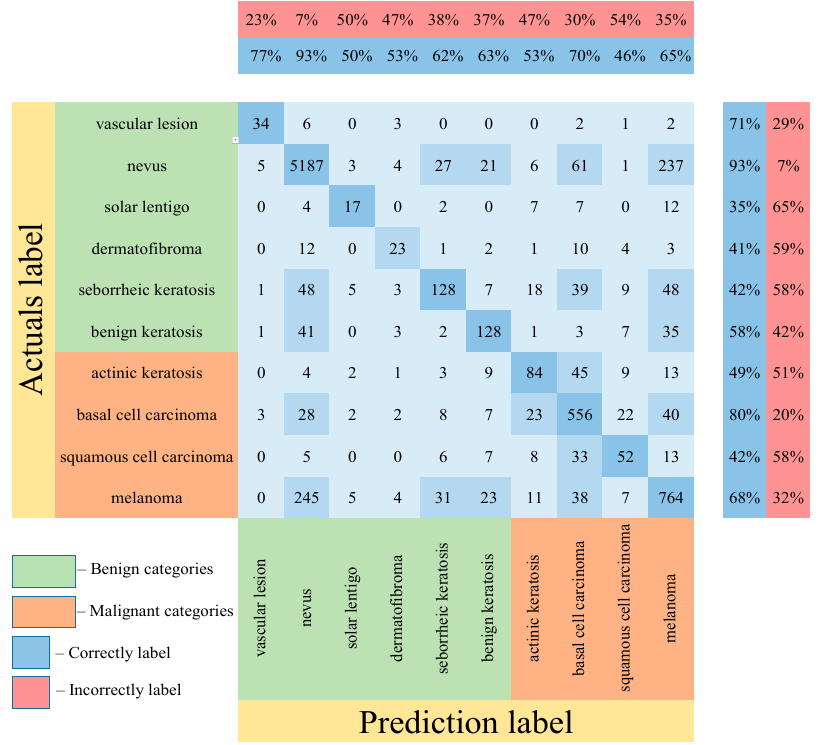
Figure 13. Confusion matrix in the testing results in a multimodal neural network system for recognizing pigmented skin lesions based on CNN AlexNet.